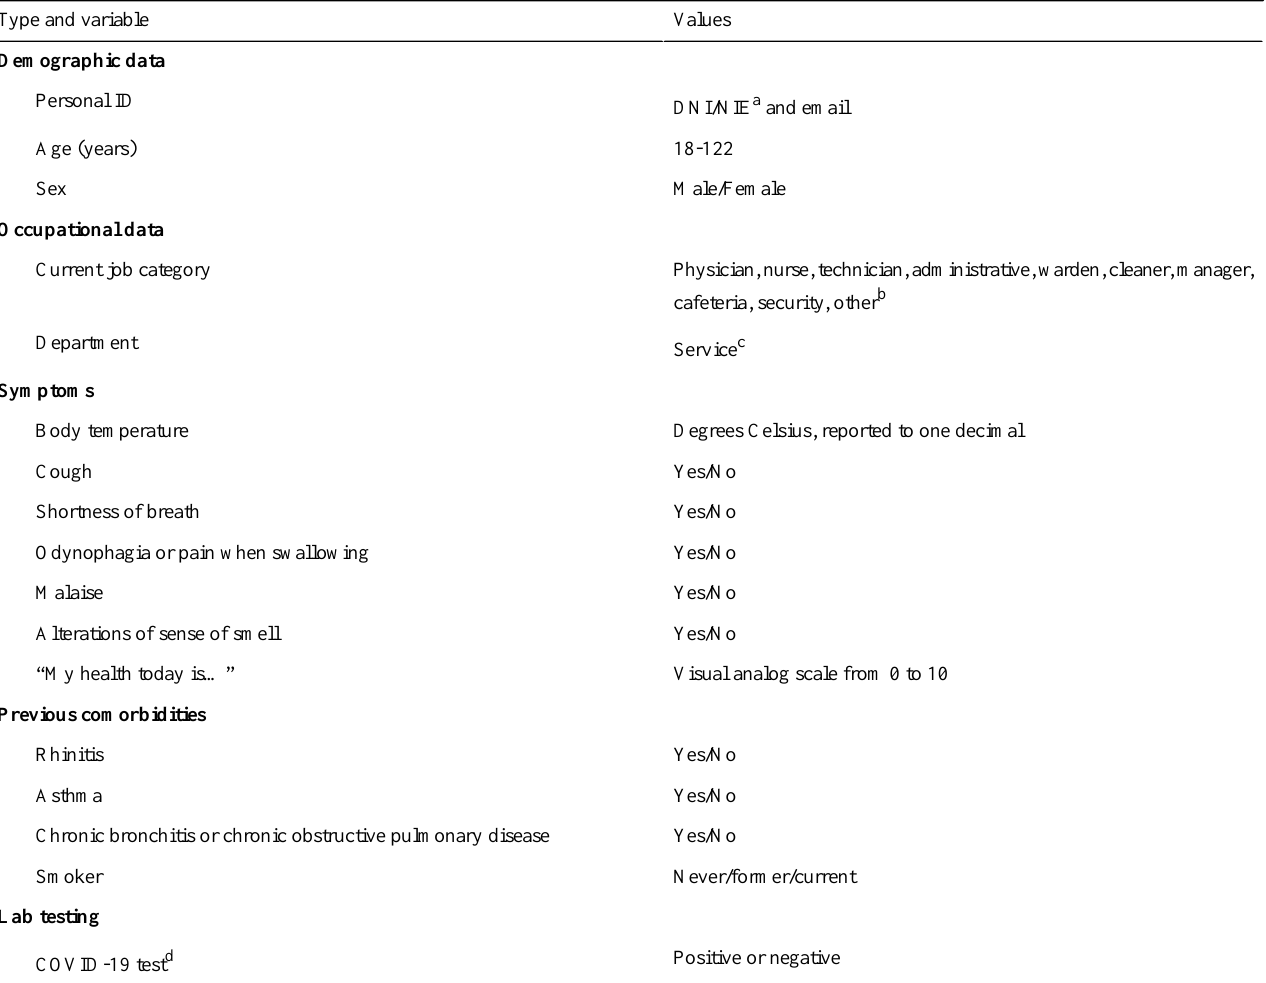
Table 1. Variables included in the HEpiTracker